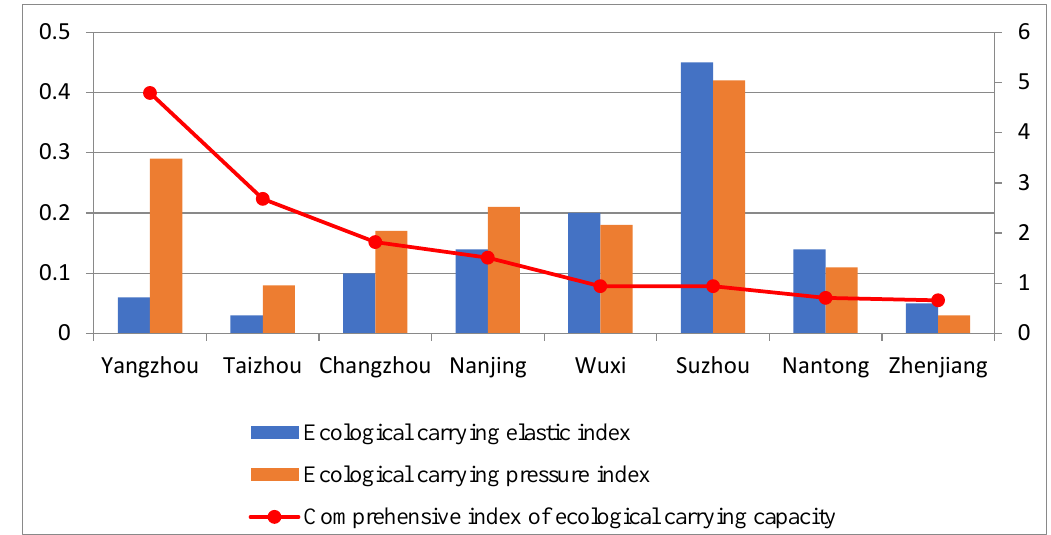
Figure 4. Comprehensive evaluation indices figure of the ecological carrying capacities for the Yangtze River urban agglomeration.